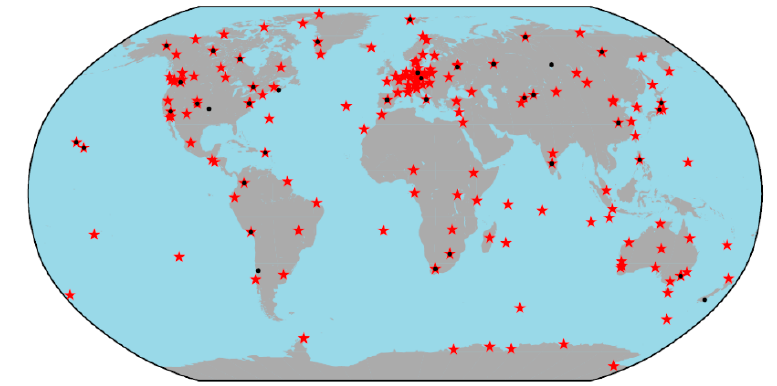
Figure 3. Geographical distribution of stations providing high-rate RINEX2 data on January 1, 2003 (black dots), and on January 1, 2014 (red stars).